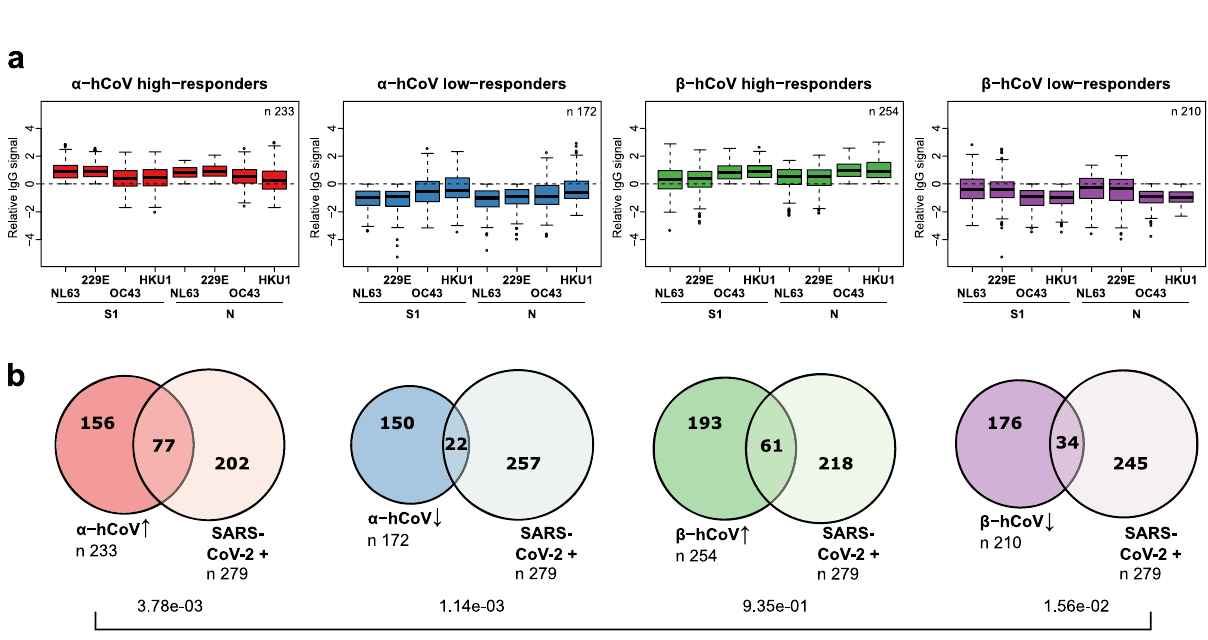
Fig. 4 Correlation of seasonal hCoV and SARS CoV-2 antibody responses. a Correlation of IgG response for the entire sample set ( n = 1176) is visualized as heatmap based on Spearman ’ s ρ coef fi cient; dendrogram on the right side displays antigens after hierarchical clustering was performed. b-c, Immune responses (IgG and IgA) towards hCoV S1 ( b ) and N ( c ) proteins are presented as Box-Whisker plots of sample MFI on a logarithmic scale for SARS-CoV- 2-infected (red, n = 310) and uninfected (blue, n = 866) individuals. Box represents the median and the 25th and 75th percentiles, whiskers show the largest and smallest values. Outliers determined by 1.5 times IQR of log-transformed data are depicted as circles. d-e, Relative levels of IgG-speci fi c immune response towards hCoV S1 ( d ) and N ( e ) proteins are presented as Box-Whisker plots/strip chart overlays of log-transformed and per-antigen scaled and centered MFI for the sample subsets of Spike Trimer false positives (blue, n = 17) and combined IgG + IgA false negatives (red, n = 31). Box represents the median and the 25th and 75th percentiles, whiskers show the largest and smallest values, excluding outliers as determined by 1.5 times IQR. Source data are provided as a Source Data fi